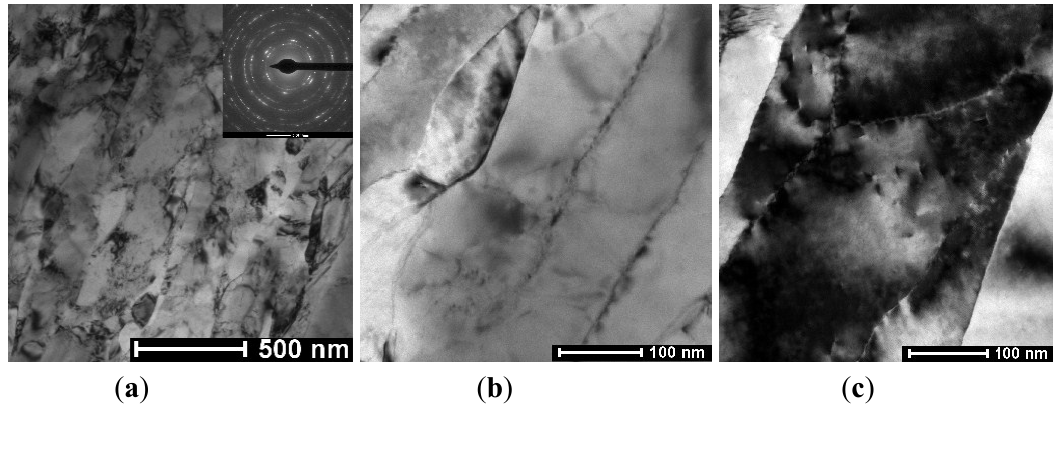
Figure 4. TEM microstructure of the ECAPed Cu-0.2wt%Mg alloy after 16 passes at 473 K. ( a ) Elongated ultra-fine grains observed at low magnification, ( b ) Elongated ultra-fine grains observed at high magnification, ( c ) characteristics of grain boundaries, ( d ) twins and intragranular dislocations, ( e ) characteristics of twins observed at high magnification and ( f ) characteristics of twins observed at the higher